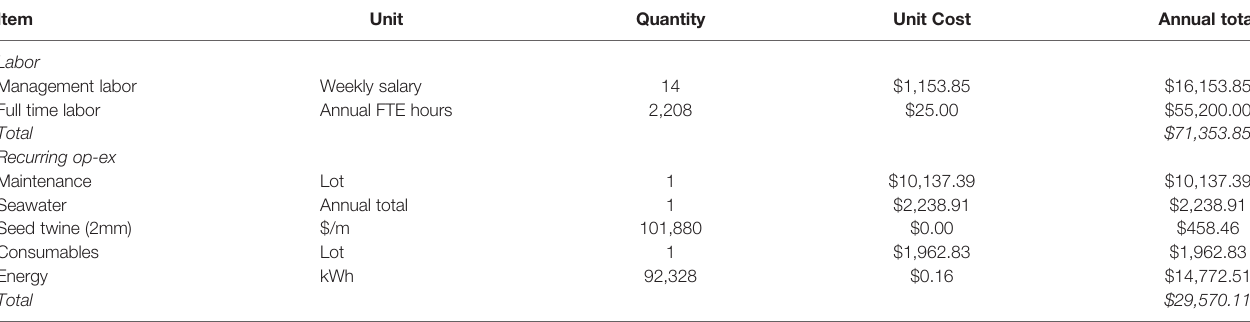
TABLE 2 | Summary of operating expenses included in the baseline techno-economic model (101,880 m of twine produced annually). Item